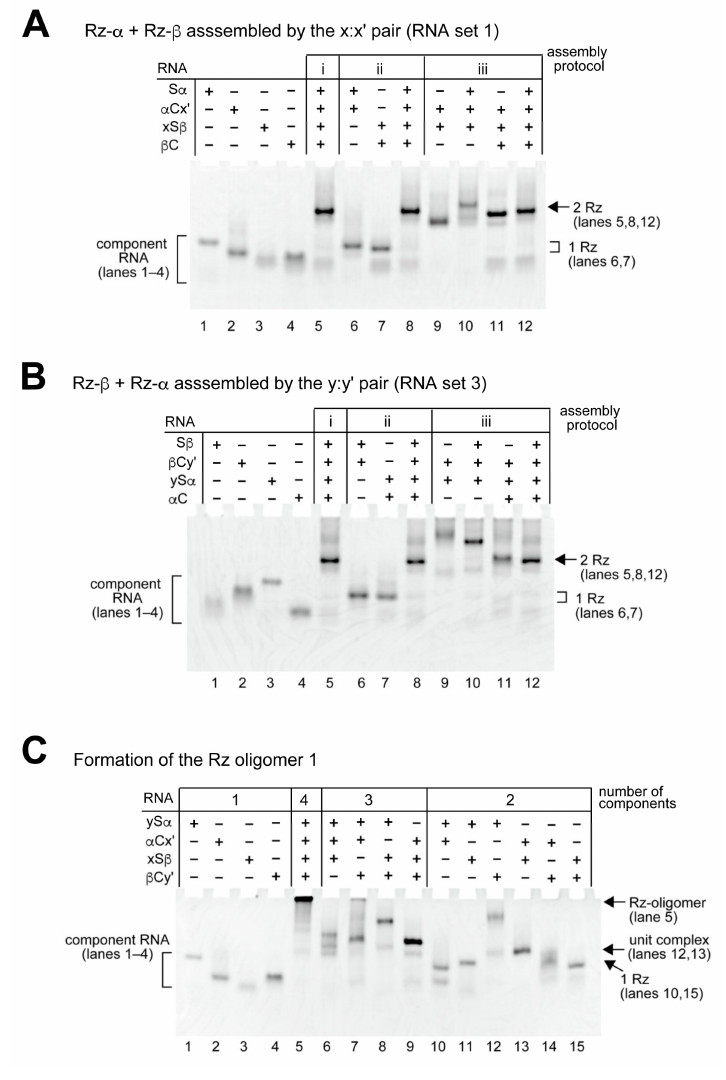
Figure 3. Formation of tetramolecular complexes and ribozyme oligomer containing Rz- α and Rz- β ribozyme units. ( A ) Formation of Rz- α + Rz- β complex mediated by x:x (cid:48) KL pair (RNA set 1). The concentration of each RNA component was 1.0 µ M. ( B ) Formation of Rz- β + Rz- α complex mediated by y:y (cid:48) KL pair (RNA set 3). The concentration of each RNA component was 1.0 µ M. ( C ) Formation of alternating co-oligomer consisting of Rz- α and Rz- β (Rz oligomer 1). The concentration of each RNA component was 0.5 µ